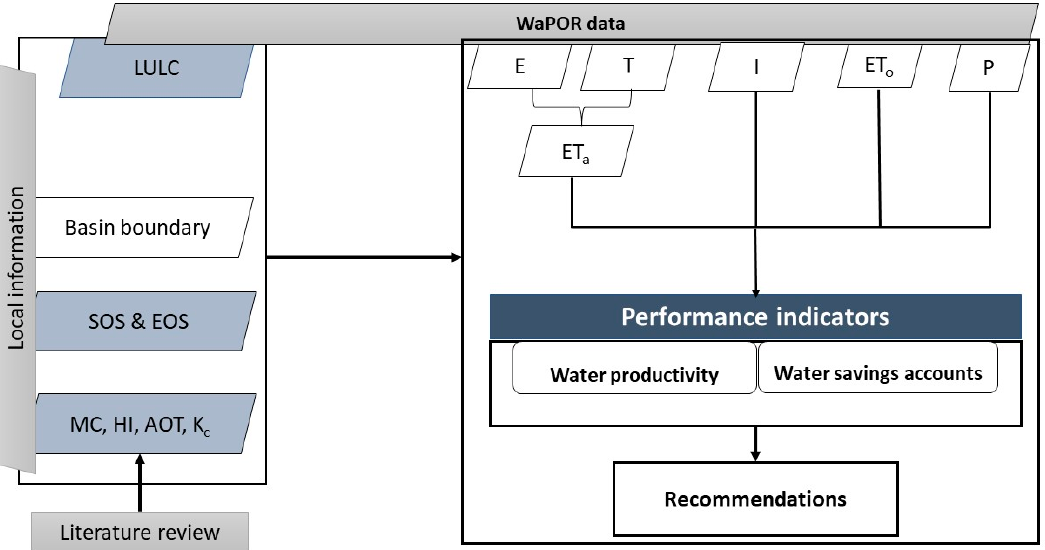
Figure 3. Simplified flowchart of the water accounting and water productivity methodology assess- ment to determine the saving potential.